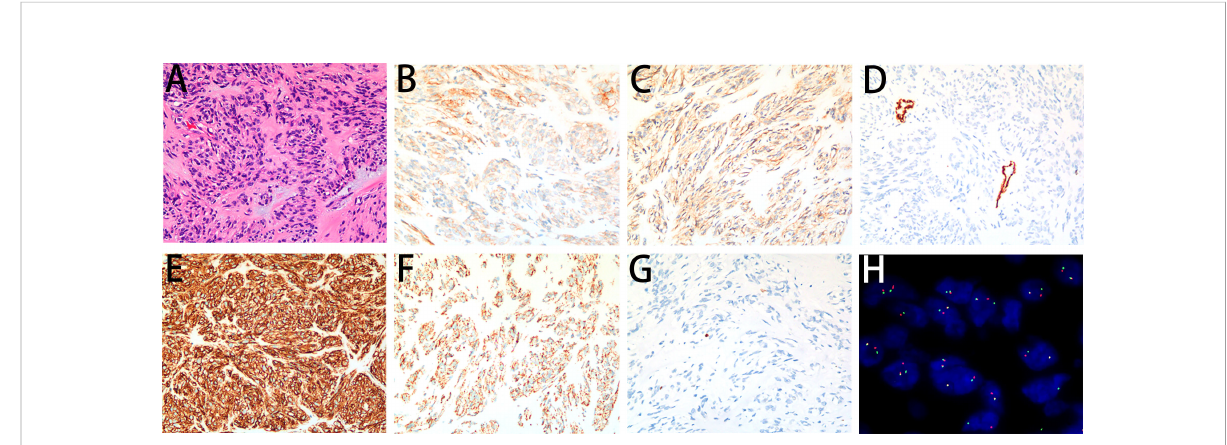
FIGURE 2 Microscopy images of the GIST. (A) The tumor demonstrated short spindle cells with red homogeneous stroma and pale blue mucus stained by H&E (200×). (B) The tumor cells showed an unequal positive cytoplasmic signal for CD117 (200×). (C) The tumor cells showed a weakly positive cytoplasmic signal for DOG1 (200×). (D) The tumor cells showed a negative cytoplasmic signal for SMA (200×). (E) The tumor cells showed a positive cytoplasmic signal for CD34 (200×). (F) The tumor cells showed a positive cytoplasmic signal for SDHB (200×). (G) The Ki-67 labelling index was 1% (200×). (H) A break-apart fl uorescent in situ hybridization (FISH) assay found FGFR2 translocation